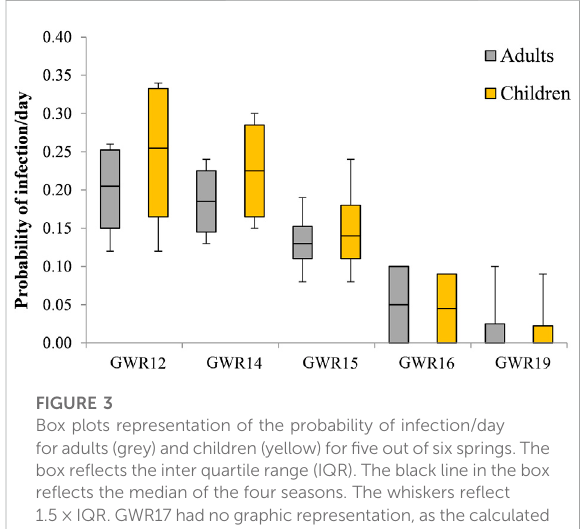
FIGURE 3 Box plots representation of the probability of infection/day foradults(grey) andchildren(yellow)for fi veoutofsixsprings. The box re fl ects the inter quartile range (IQR). The black line in the box re fl ects the median of the four seasons. The whiskers re fl ect 1.5 × IQR. GWR17 had no graphic representation, as the calculated value for risk of infection/day was